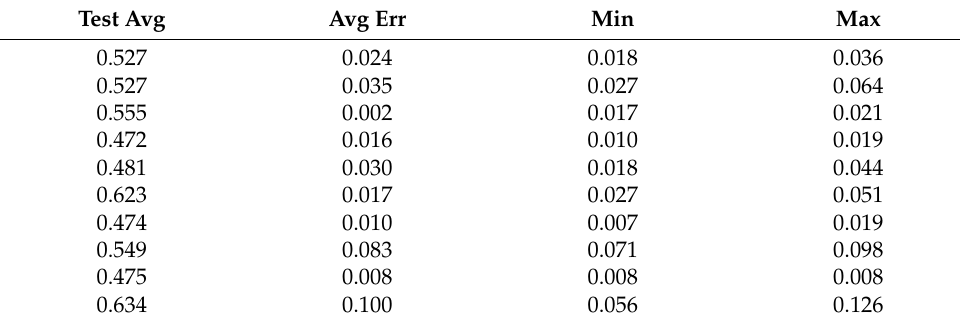
Table A36. Set 1, trials 21–30 data (single 0.5 PR value).